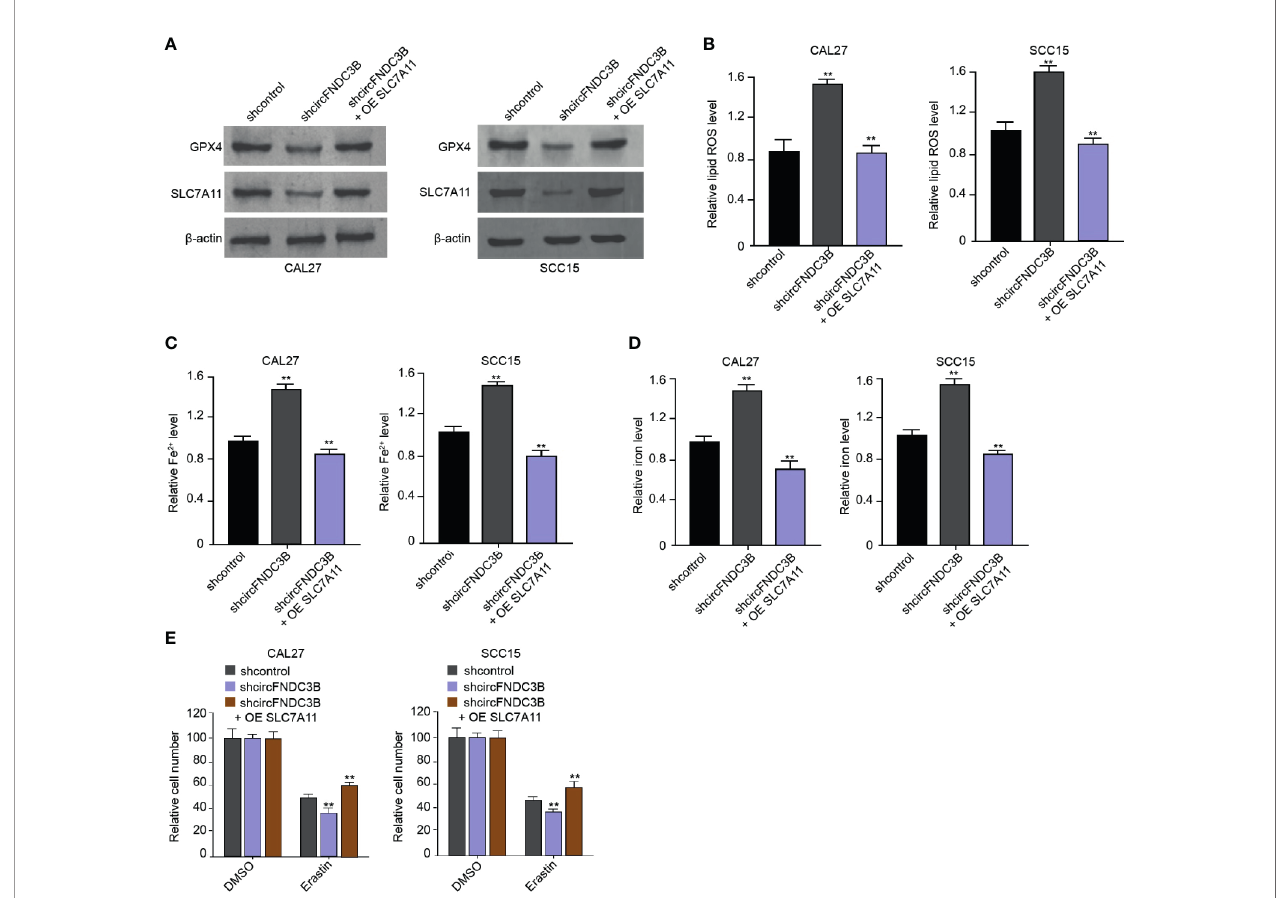
FIGURE 5 | CircFNDC3B represses ferroptosis of OSCC cells by inducing SLC7A11 expression. (A – E) The circFNDC3B shRNA and pcDNA3.1-SLC7A11 were applied to co-treat CAL27 and SCC15 cells. (A) Western blot of GPX4 and SLC7A11 expression. (B – D) Analysis of ROS, iron, and Fe 2+ levels. (E) CCK-8 assays of cell viability. N = 3, mean ± SEM: ** P <